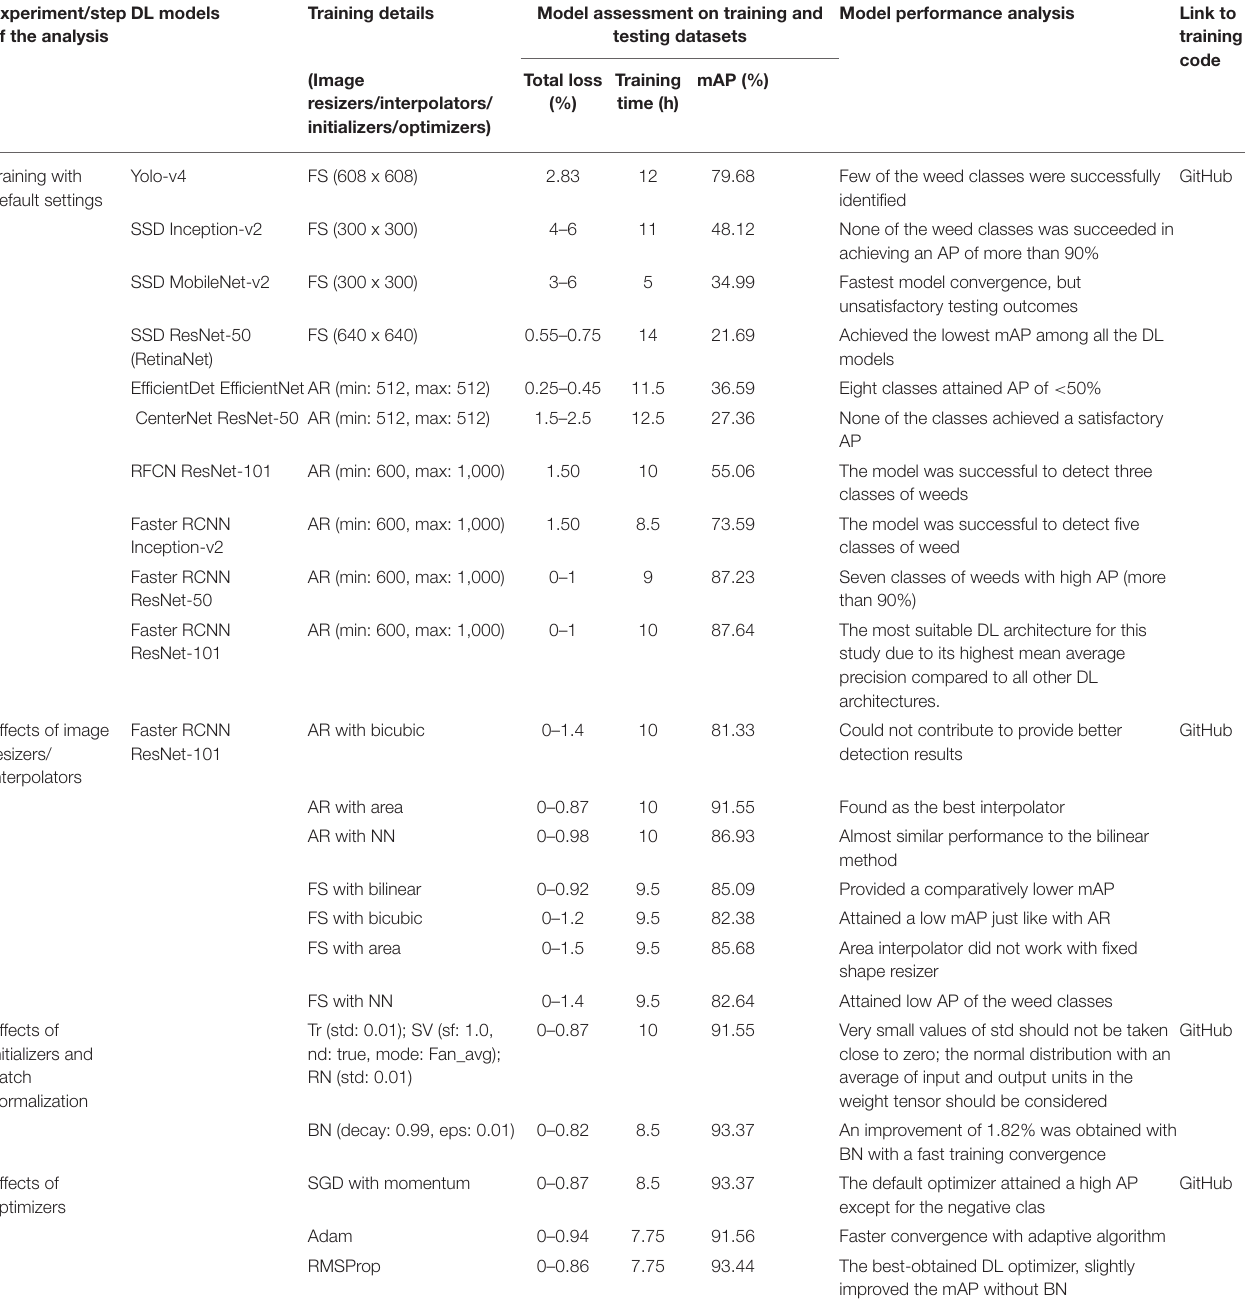
TABLE 4 | Summary of results and conclusions from each step of the proposed